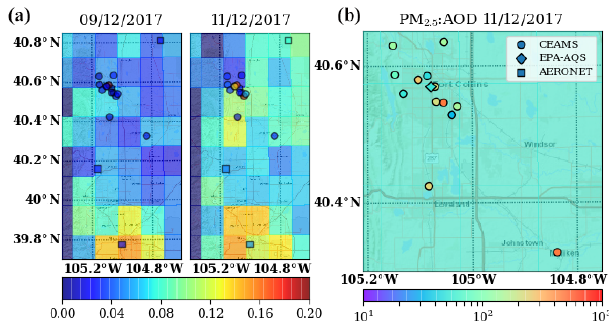
Figure 9. MODIS AOD overlaid with CEAMS (circles) and AERONET (boxes) AOD for 9 and 11 December 2017 in north- ern Colorado (a) and PM 2 . 5 :AOD ratio (described in text) from CEAMS for 11 December 2017 ( b , note different spatial scale). In the right panel, the background color represents the value that would be assumed for the whole region if relying only on the single EPA- AQS monitoring site located at the CSU Facilities. Maps generated using World Street Maps (credit: Esri, HERE, Garmin, USGS, In- termap, INCREMENT P, NRCan, Esri Japan, METI, Esri China – Hong Kong, NOSTRA, ©OpenStreetMap contributors, and the GIS user community). ©OpenStreetMap contributors 2019.